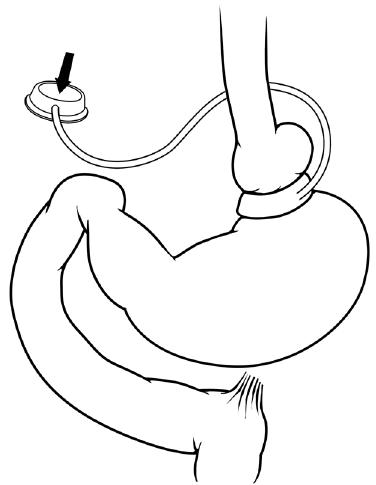
Figure 3. Adjustable gastric banding. In this operation, an external ring is placed around the proximal portion of the stomach and has a balloon that lines the inside portion of the ring. The inflatable balloon is connected to a port in the subcutaneous tissue of the upper abdomen that allows the balloon volume, and therefore the amount of external gastric restriction, to be adjusted. Reprinted with permission 35